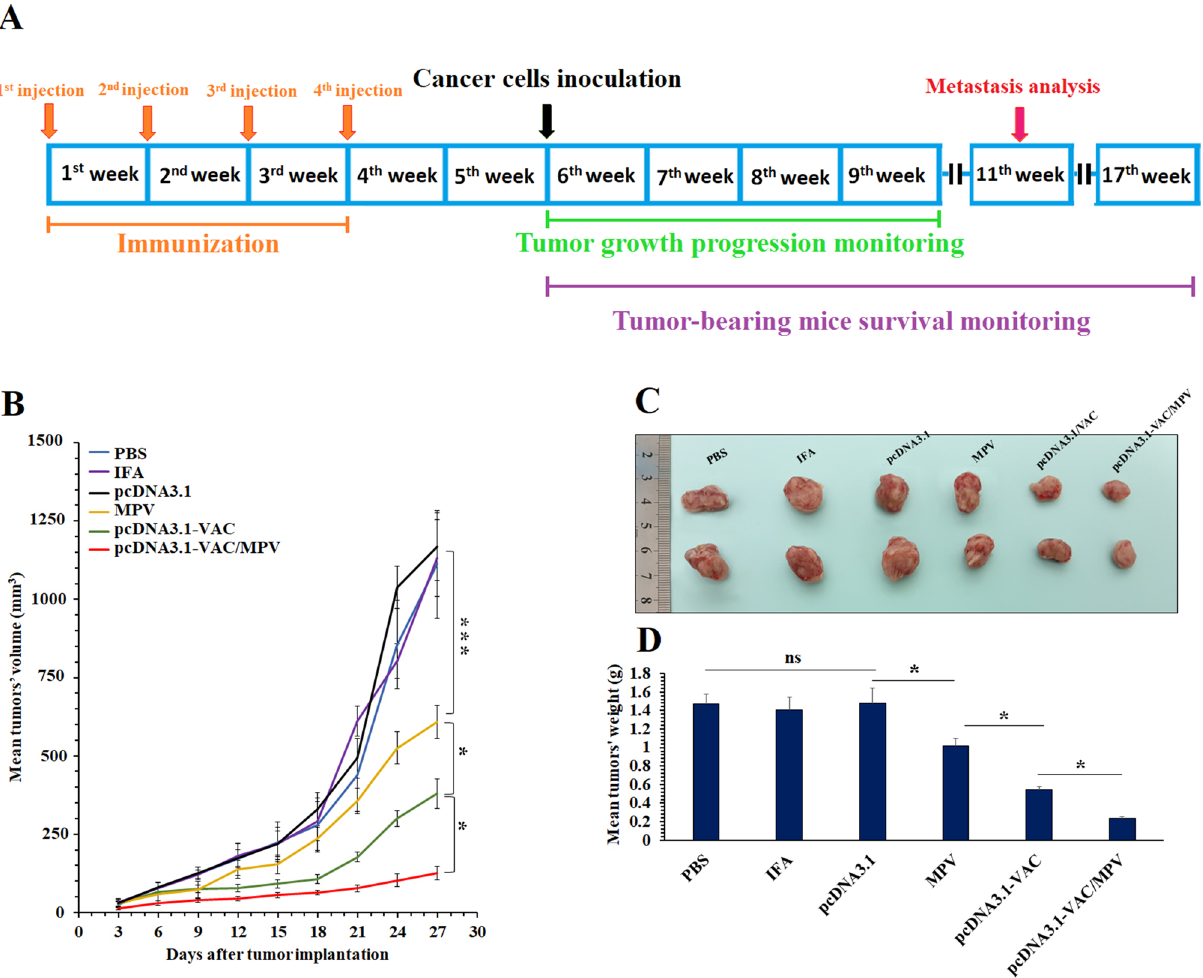
Figure 3. The anti-tumor effects of prophylactic immunization with the multiepitope peptide and DNA vaccines at different immunization groups. ( A ) Schematic illustration of time arrangement of immunization, cancer cells inoculation, tumor growth progression monitoring, tumor-bearing mice survival monitoring, and metastasis analysis. ( B ) The tumors’ growth progression at the PBS, IFA, pcDNA3.1, MPV. pcDNA3.1-VAC and pcDNA3.1-VAC/MPV immunized groups (n = 5). It should be mentioned that the cancer cells were inoculated two weeks after the last immunization. The tumor inoculation day was determined as day 0 at the tumor growth progression chart. ( C ) The photograph of harvested tumors on the 27th day after the cancer cells implantation (2 samples from each group). ( D ) The mean weight of harvested tumors at different immunization groups on the 27th day after the cancer cells implantation (n = 5). 05 (*: 0.05 ≥ P > 0.01, **: 0.01 ≥ P > 0.001, ***: P < 0.001, ns: not